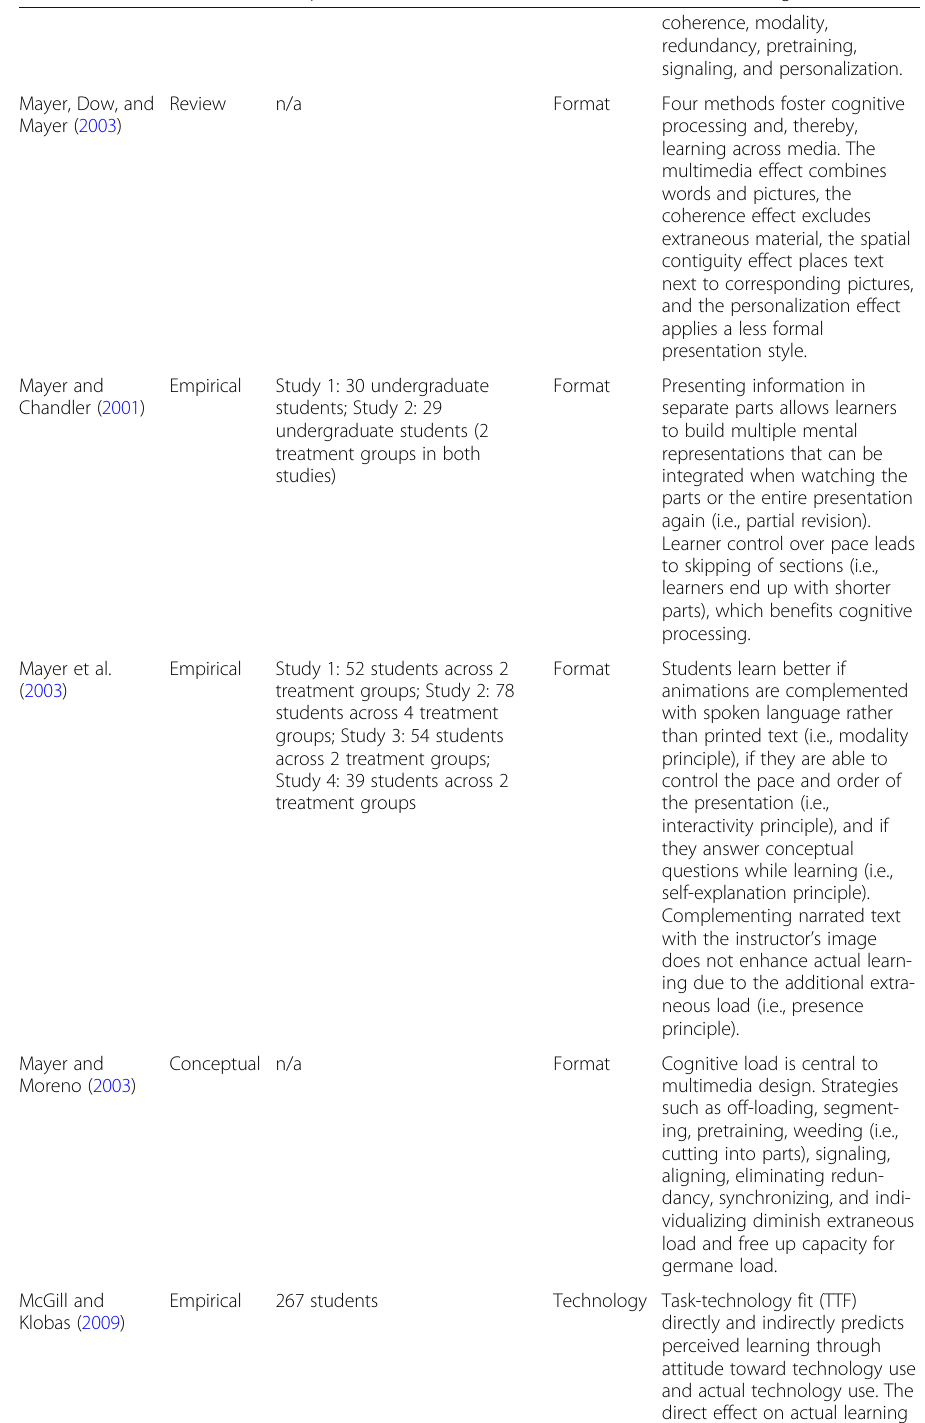
Table 1 Overview of Findings from the Extant Literature (Continued)